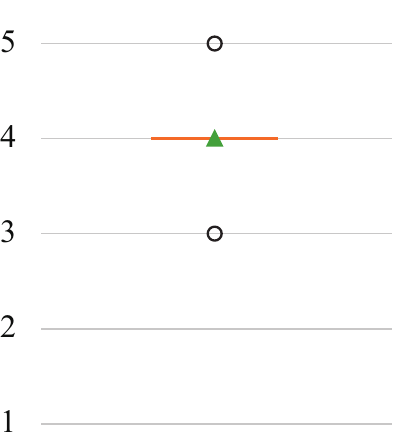
Figure 20. Result of the question, “The AR texture looks like a real moving